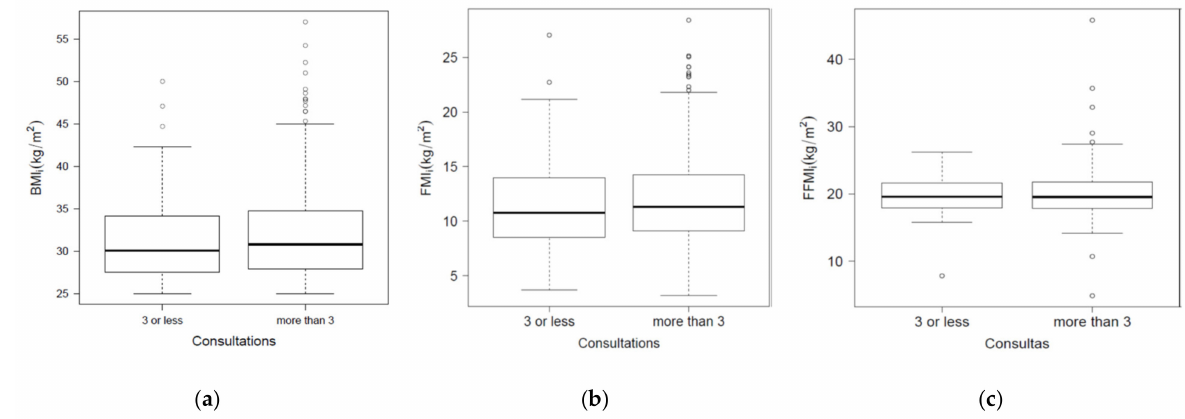
Figure 1. Boxplots comparing the groups based on attendance for: ( a ) BMI i ; ( b ) FMI i and ( c ) FFMI i . body mass index (BMI); fat mass index (FMI); fat-free mass index (FFMI); initial (i); ≤ 3 consultation attendance ( ≤ 1.5 months); attendance to >3 consultations (>1.5